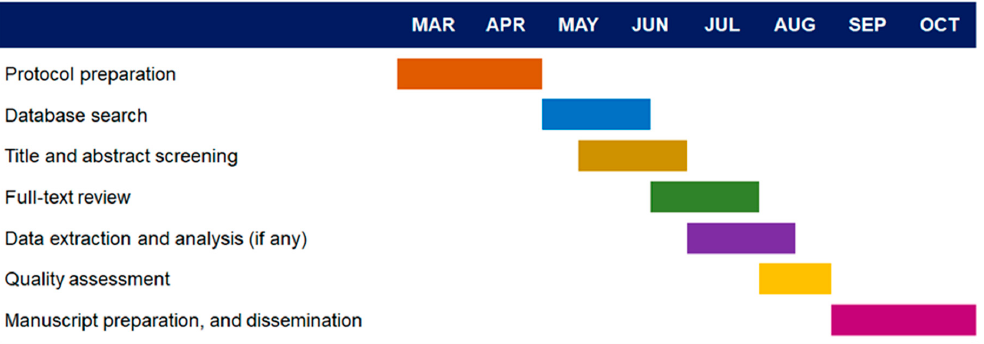
Figure 1. Gantt chart describing the proposed timeline for this review including each of the three outcomes of interest. Months are for the year 2022.